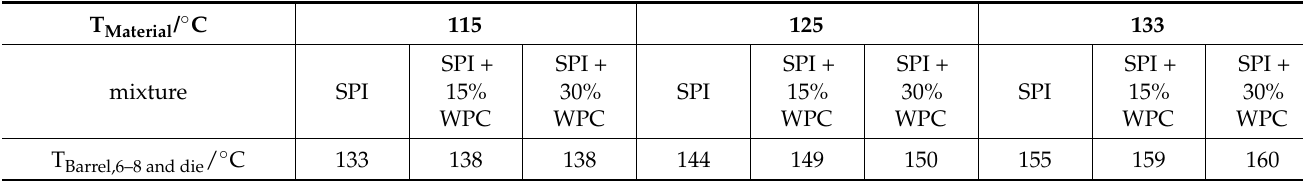
T Barrel,6–8 and die / ◦